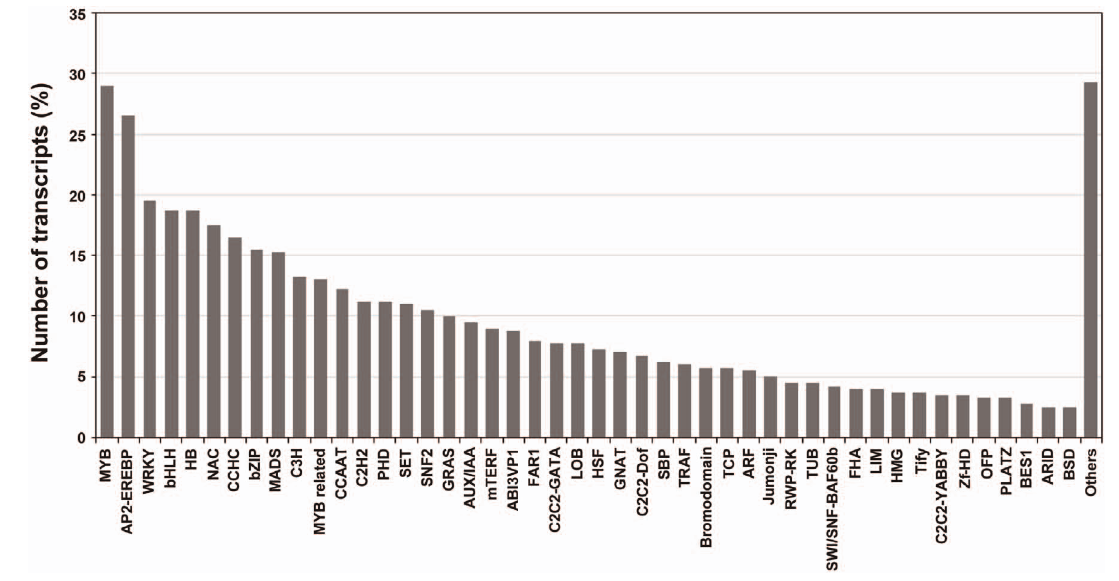
Figure 1. Number of transcripts representing different transcription factor families in C.roseus transcriptome.